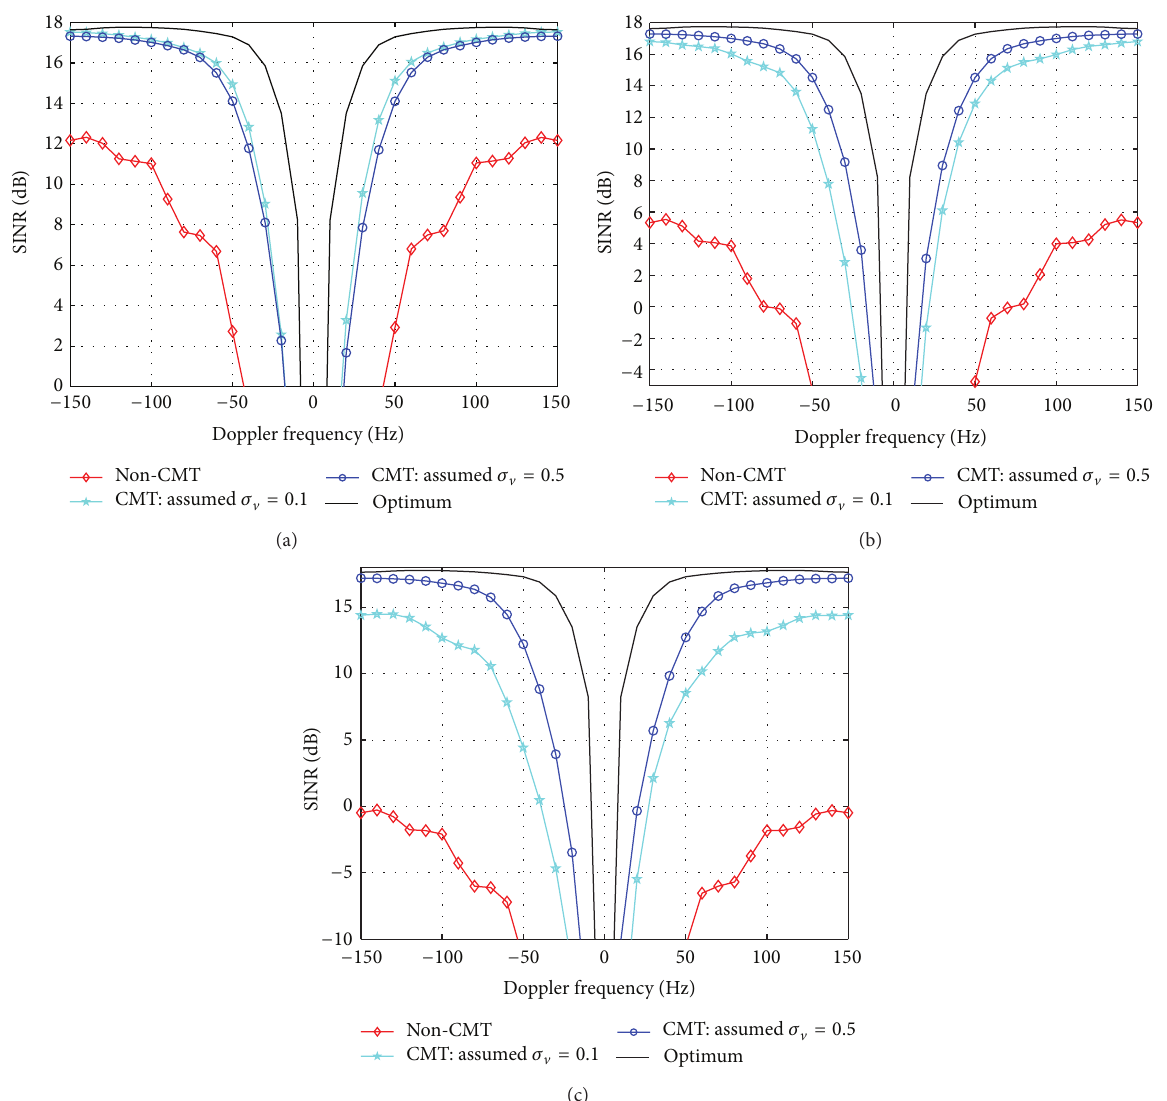
Figure 5: Impacts of yaw angle misalignment of prior knowledge on SINR performance against Doppler frequency with 4 snapshots and the target Doppler frequency space from − 150 to 150 Hz: (a) yaw angle misalignment 0.2 ∘ , (b) yaw angle misalignment 0.5 ∘ , and (c) yaw angle misalignment 1 ∘